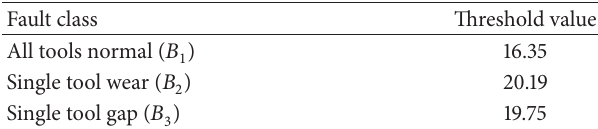
Table 3: The values of threshold 𝐷 (𝑖) 0.01 of three fault